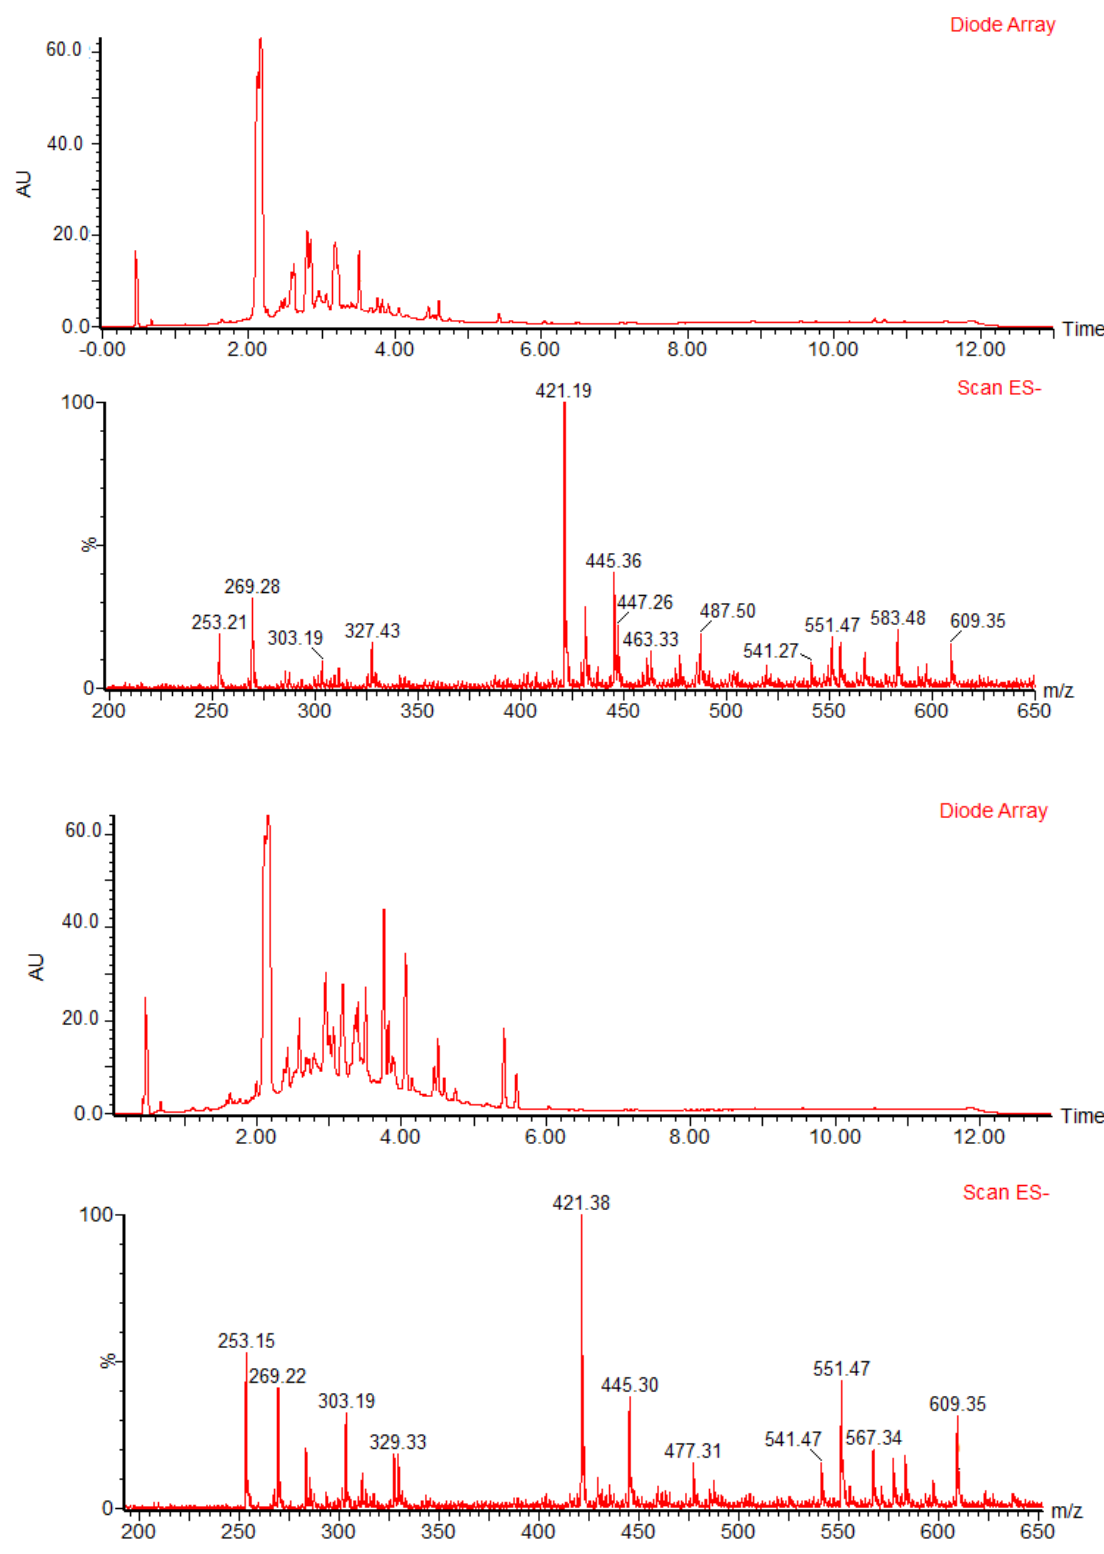
FIGURE 1 – UPLC fingerprint (A and C) and Full scan mass spectrum (B and D) of the ethanolic extracts from Fridericia samydoides leaves (A and B) and stems (C and D) . Chromatographic conditions: see Experimental